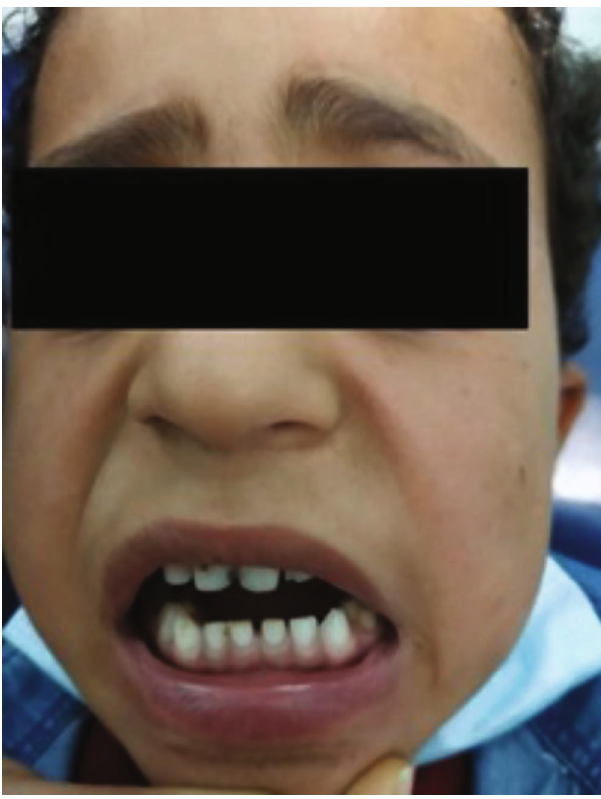
Figure 1: Front view showing facial asymmetry with mandibular deviation towards the left